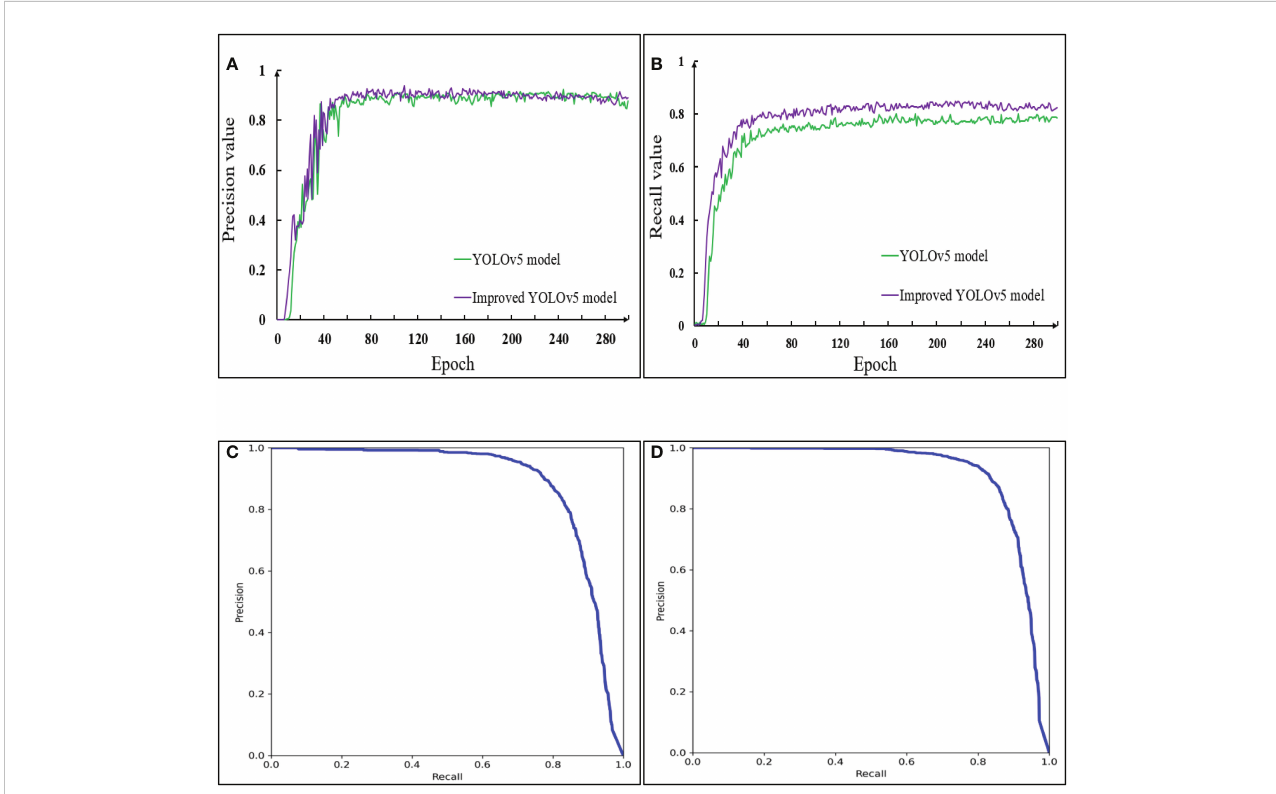
FIGURE 13 Comparison of P-R curve between YOLOv5 model and improved YOLOv5 model in the testing set. (A) Precision; (B) Recall; (C) P-R curve of the YOLOv5; (D) P-R curve of the Improved